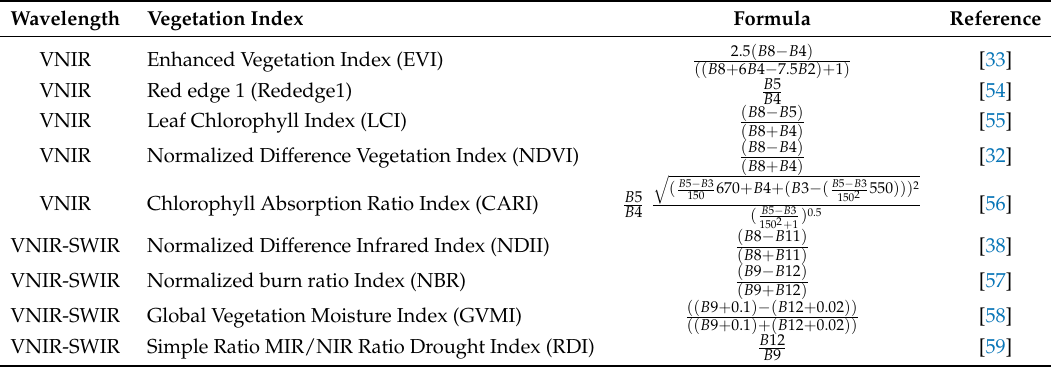
Table 4. Evaluated spectral vegetation indices derived from